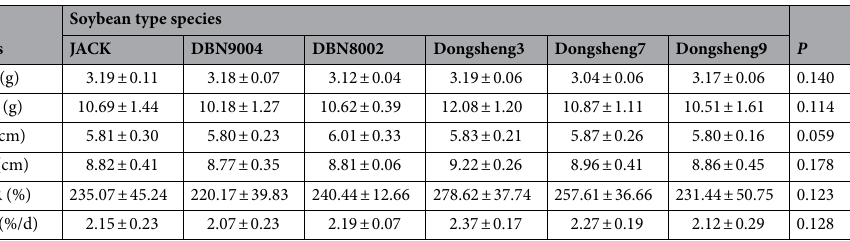
Table 3. The effects on the growth performance of channel catfish fed transgenic soybeans (n = 25). IBW, Initial body weight; FBW, final body weight; IBL, initial body length; FBL, final body length; WGR, weight gain rate; SGR, specific growth rate. p < 0.05 indicates significant differences among the six experimental groups.